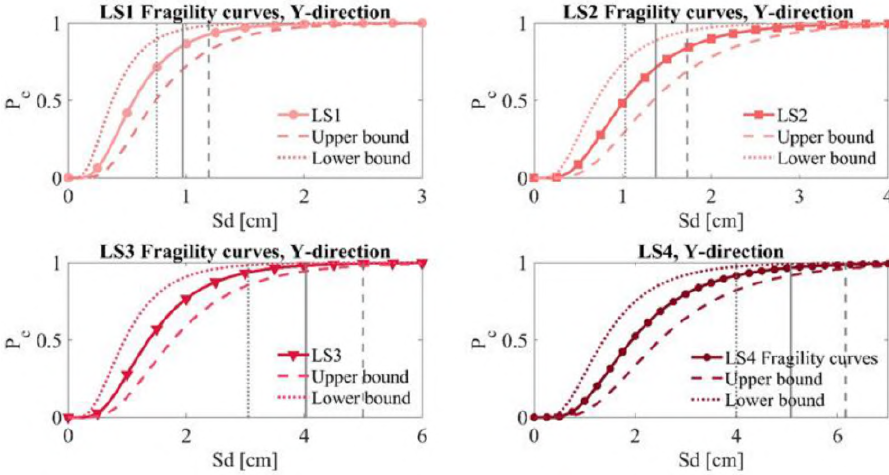
Figure 17. Mean, upper and lower fragility curves for the four limit states of interest, in the Y-direction.